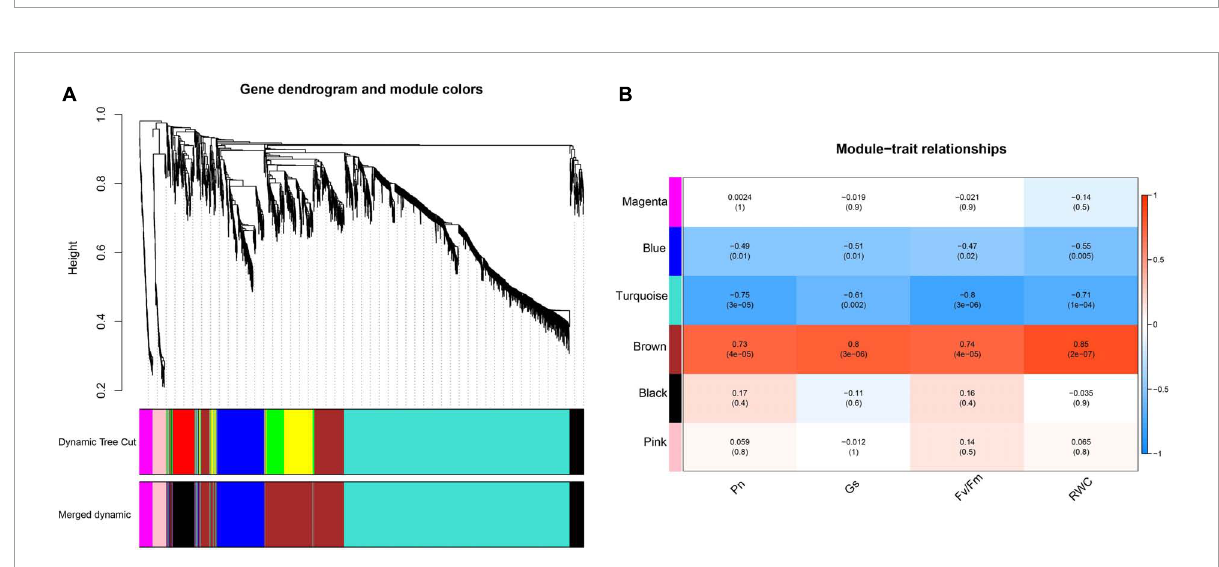
FIGURE9 Network analysis dendrogram showing modules identified by WGCNA. (A) Hierarchical cluster tree showing 9 co-expression modules (including gray module) identified by WGCNAs, each branch in the tree represents an individual gene; (B) Correlation between module eigengenes and photosynthetic parameters, each cell contains the corresponding correlation and p